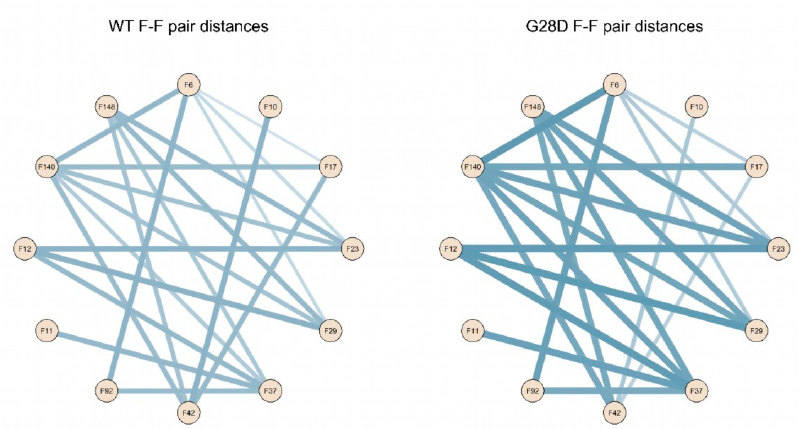
Figure 6. Schematic representation of F-F pair distances in the wild type and G28D. Intramolecular cohesions in the simulated FG domains are shown as a schematic representation of F-F distances in the wild type and G28D with lines whereby the thickness increases with the